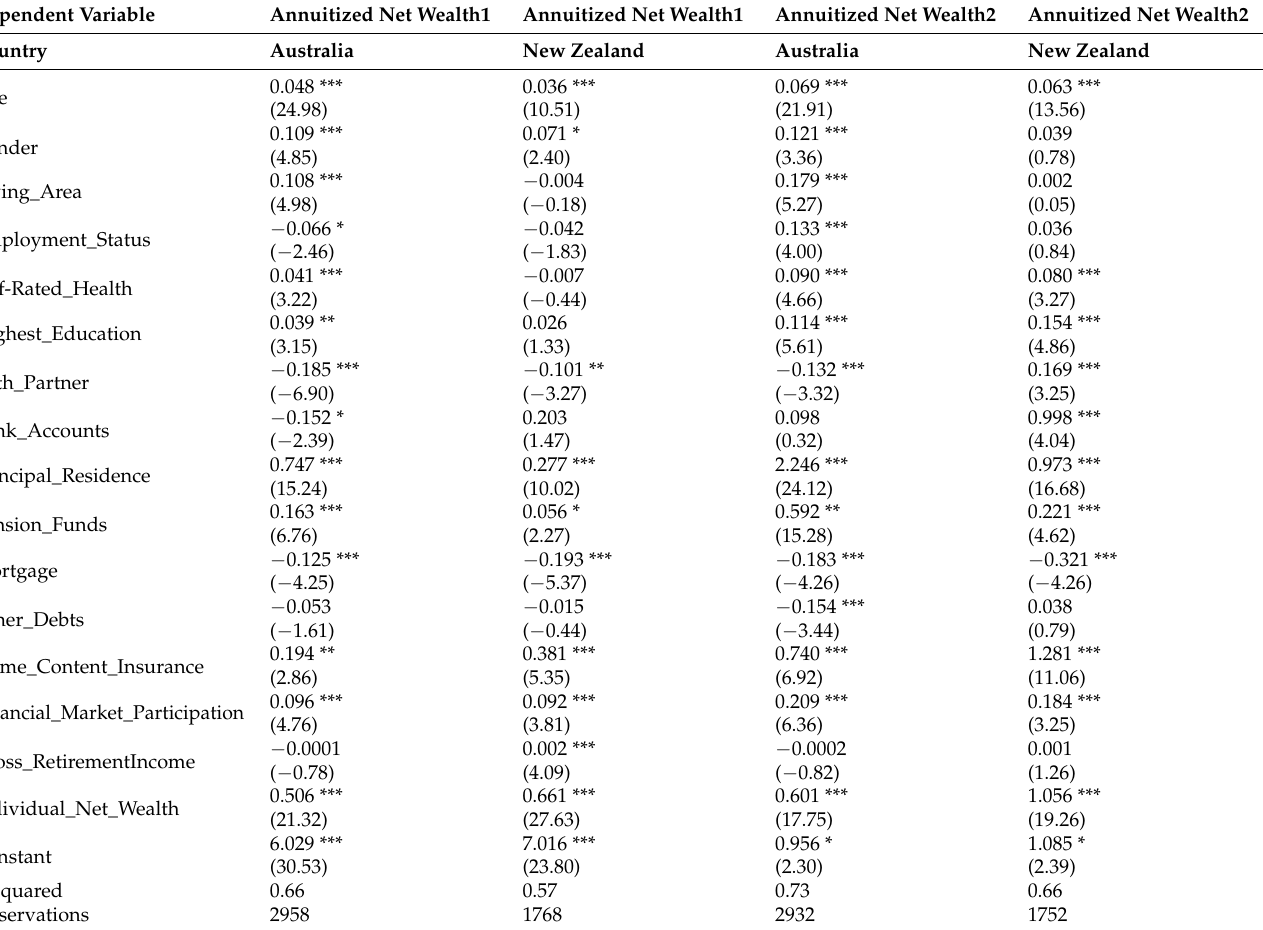
Table A3. OLS results of single country regression for objective income sufficiency with all the